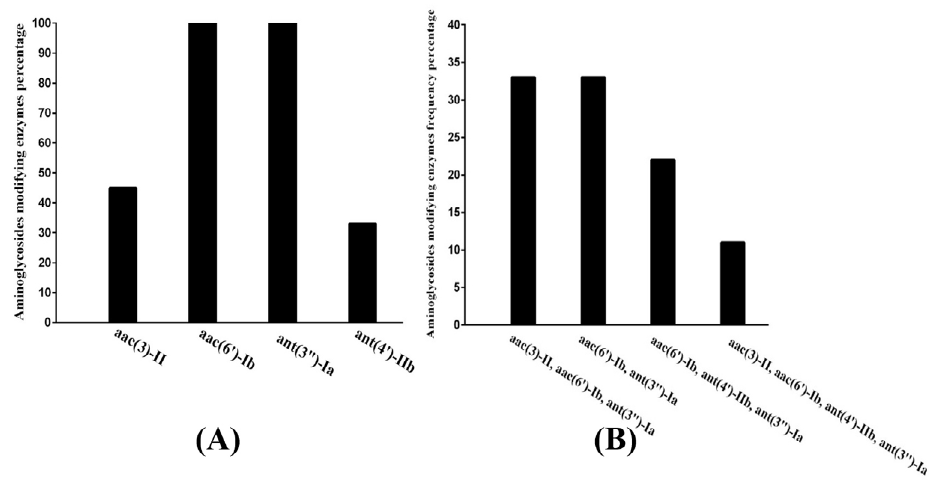
Fig. 1. Distribution of resistance genes in the highest resistant isolates: A- Percentage of single gene in isolates B- Percentage of co-existence genes isolates